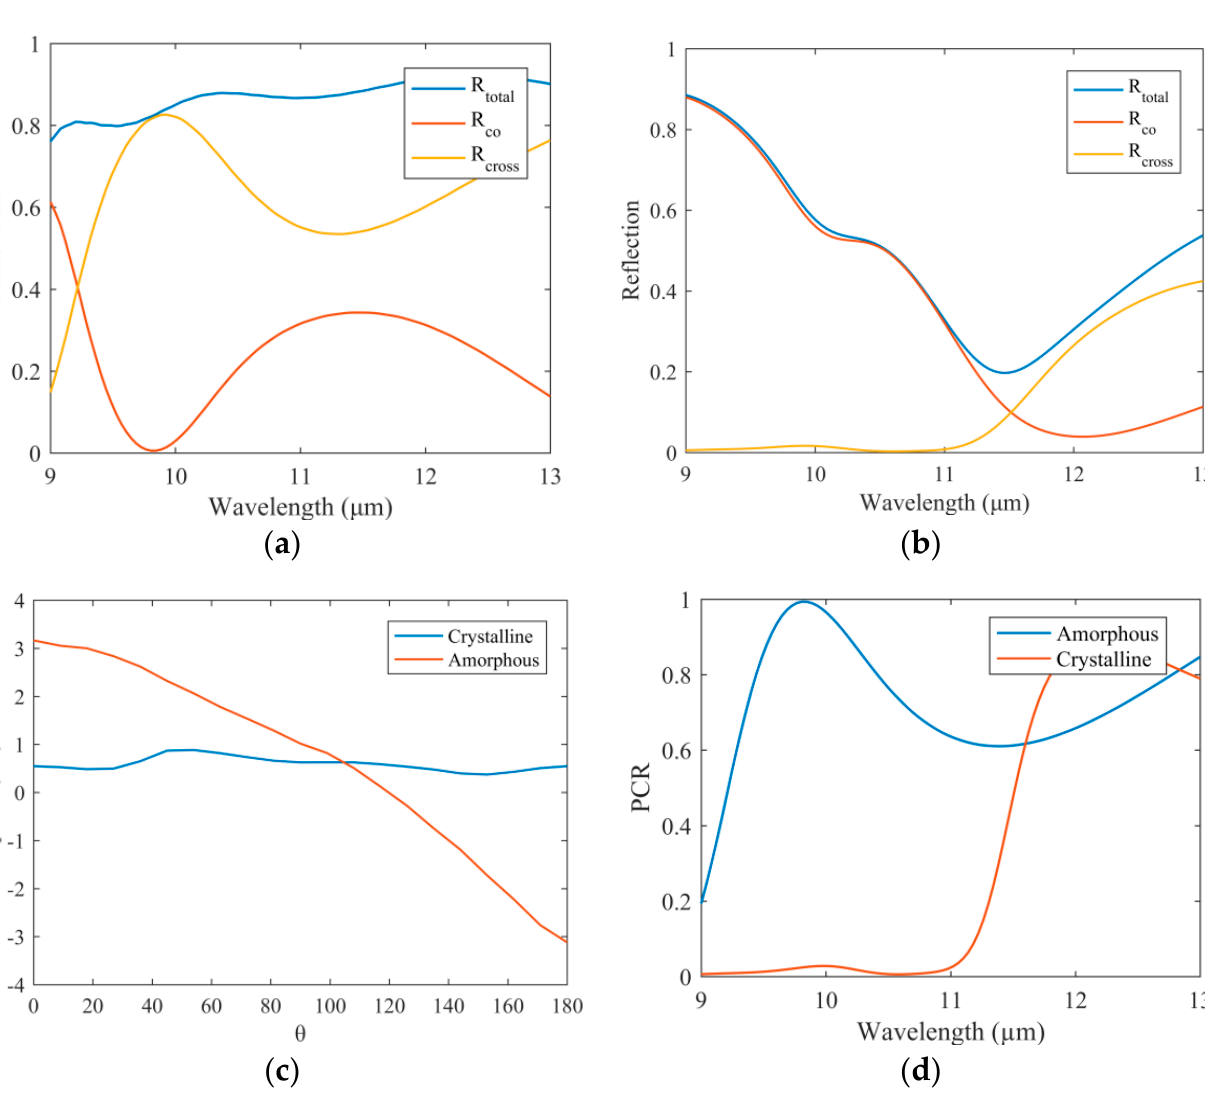
Figure 2. The total, co-polarized, and cross-polarized components of reflection for ( a ) amorphous and ( b ) crystalline states of GST layers. ( c ) The phase shift versus varied rotation angles of the U-shaped antenna and ( d ) the PCR spectrum before and after the amorphous-to-crystalline phase tran- sition.